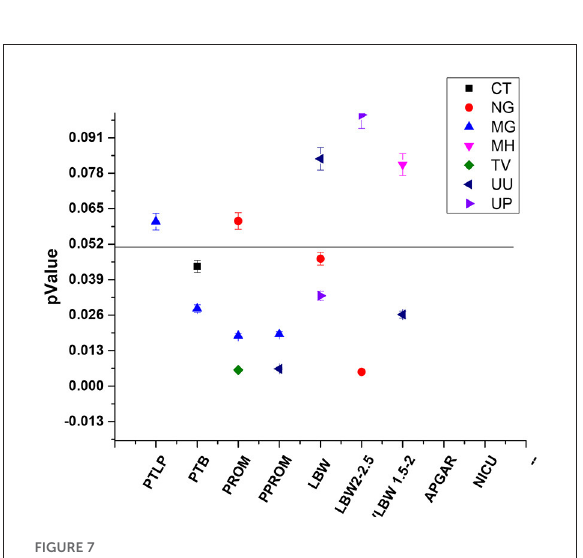
FIGURE7 Statistically significant association between STIs/RTIs with maternal and fetal adverse outcomes.